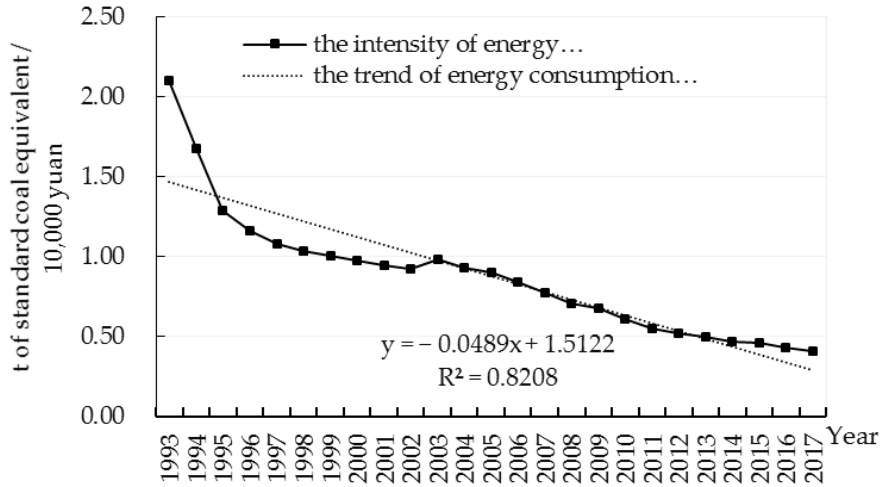
Figure 2. Energy consumption intensity in Zhejiang Province (1993 to 2017). Data source: China Environmental Statistics Yearbook, Zhejiang Statistical Yearbook.